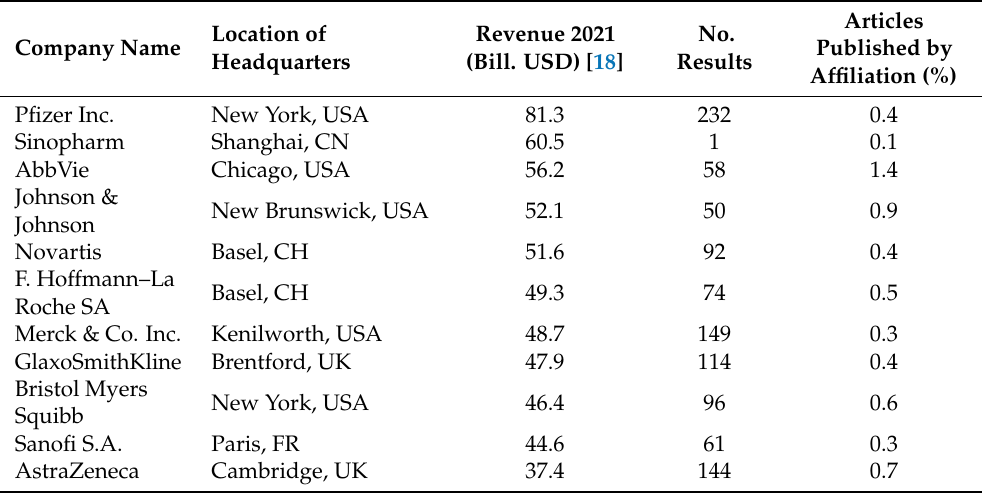
Table 1. Publication metrics on the topic of “in vitro permeability testing” for the 11 largest pharma- ceutical companies